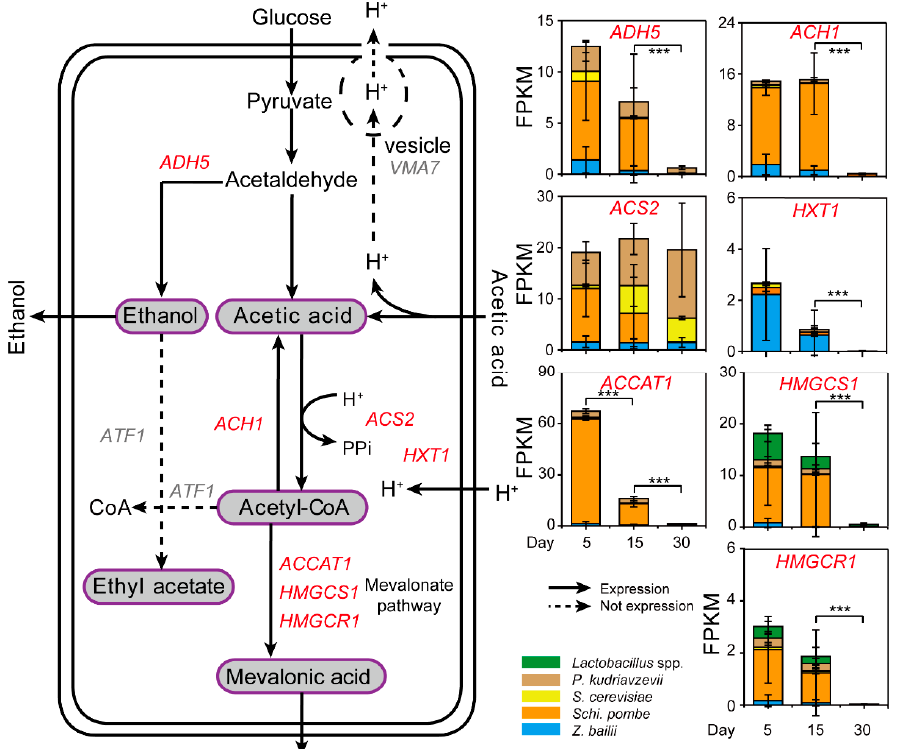
Figure 4. The differentially expressed genes of core yeast species ( P . kudriavzevii , S . cerevisiae , Schi . Pombe, and Z . bailii ) and Lactobacillus spp. related to acetic acid conversion on day 5, 15 and 30 during Baijiu production. According to the Kyoto Encyclopedia of Genes and Genomes (KEGG) database, these genes include alcohol dehydrogenase 5 ( ADH5 , K00121), acetyl-CoA hydrolase ( ACH1 , K01067), acetyl coenzyme A synthetase 2 ( ACS2 , K01895), hexose transporter ( HXT1 , K08139), V-type H+-transporting ATPase subunit F ( VMA7 , K02151), alcohol acetyltransferase 1 ( ATF1 ), acetyl-CoA and hydroxymethylglutaryl-CoA reductase 1 (NADPH) ( HMGCR1 , K00021) in the core yeast species P. kudriavzevii , S. cerevisiae , Schi. Pombe, and Z. bailii . The genes related to different species are showed in different colors: P. kudriavzevii (brown), S. cerevisiae (yellow), Schi. pombe (orange) and Z. bailli (blue). Data are expressed as mean ± SD from biological triplicates. Error bars indicate standard deviation from three independent sampling points and asterisks represent significant differences between the two groups (*** p < 0.001, Mann–Whitney U test).